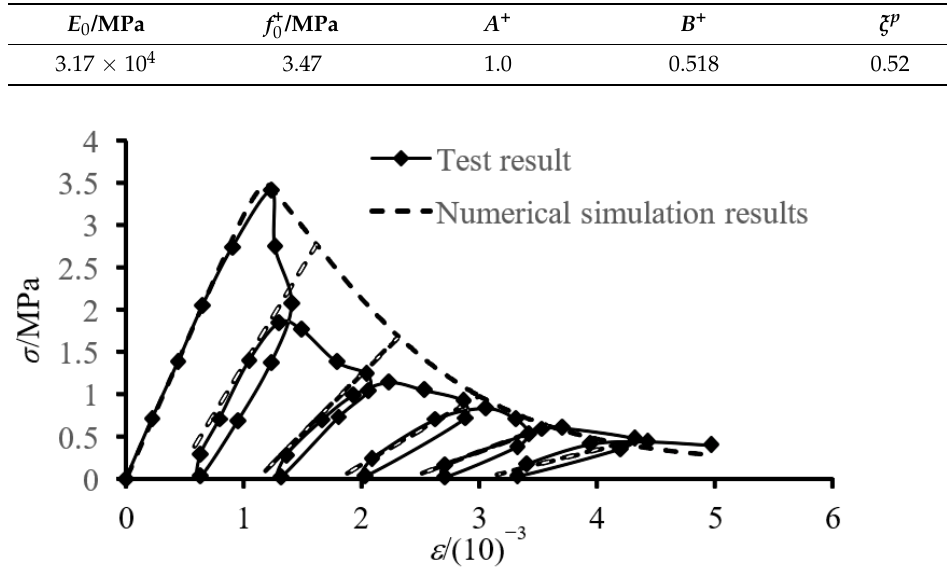
Figure 4. Comparison of numerical simulation result and experimental result (cyclic tensile test). Table 4. Simulation parameters of the cyclic tensile